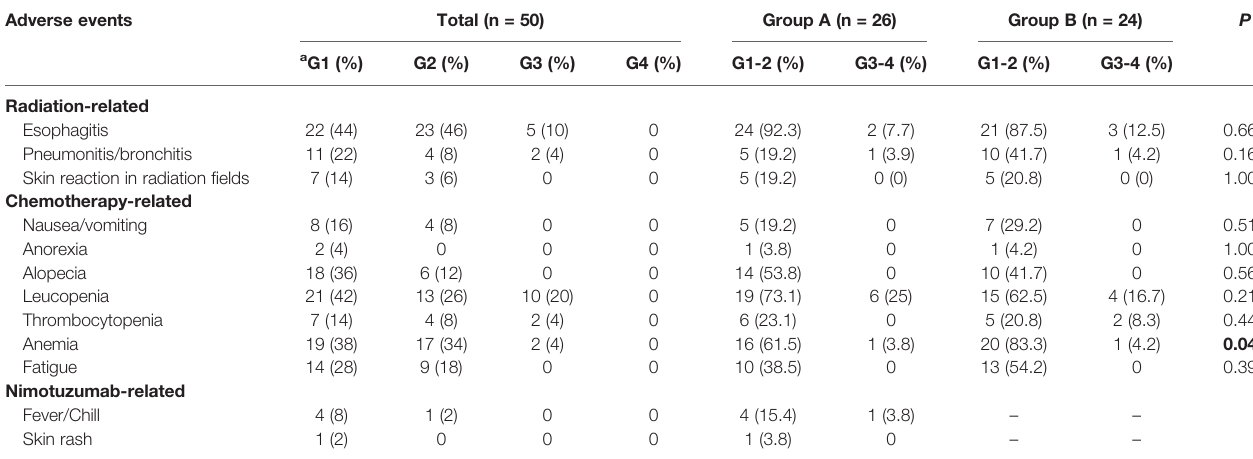
TABLE 2 | Treatment-related adverse events in 50 patients. Adverse